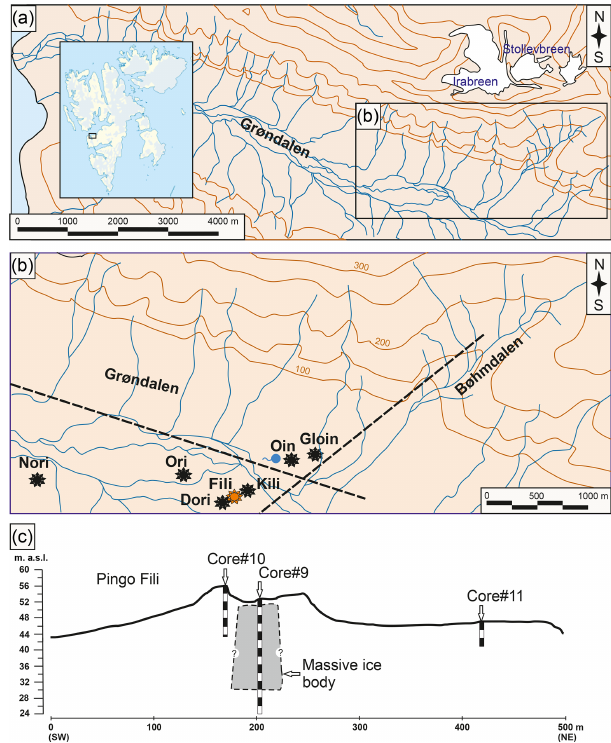
Figure 1. Study region of Nordenskiöld Land on west Spitsber- gen (inset), showing (a) the position of Grøndalen, (b) the position of seven pingos in Grøndalen (redrawn after https://toposvalbard. npolar.no, last access: 1 April 2019), the spring location (blue cir- cle), and estimated fault locations (dotted lines) and (c) the drilling profile across Fili pingo (shown as an orange star in b ) with loca- tions of cores 9, 10 and 11. Please note that the actual lateral extent of the massive pingo ice body is